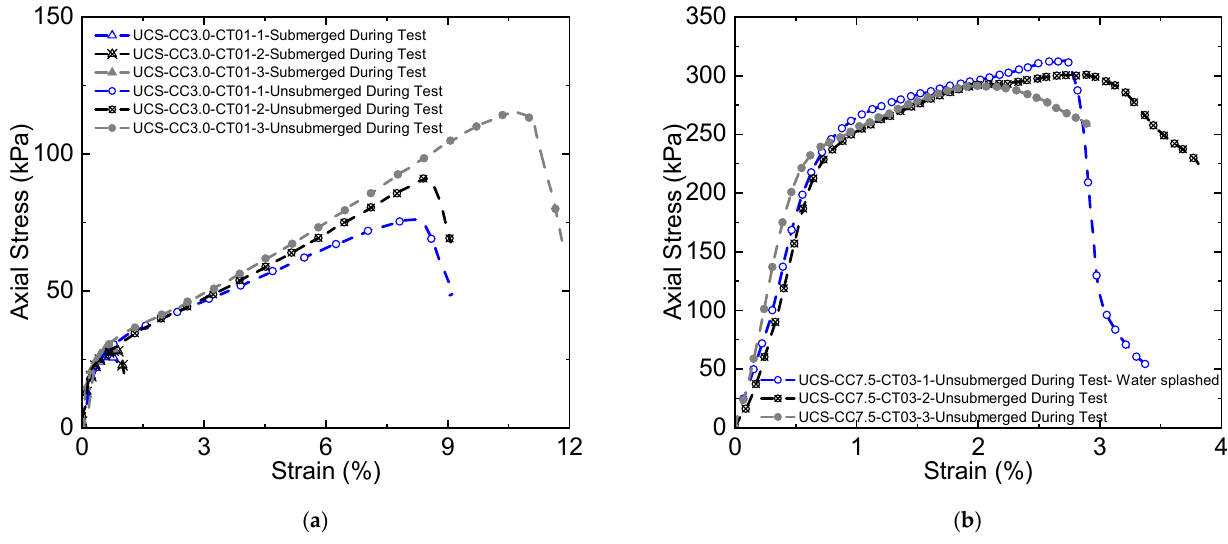
Figure 3. ( a ) Comparison of peak stresses obtained from three samples tested submerged, and three samples tested in air; ( b ) comparison of three samples tested in air, with one of these samples sprayed with water near its peak stress leading to internal suction loss and sample failure.